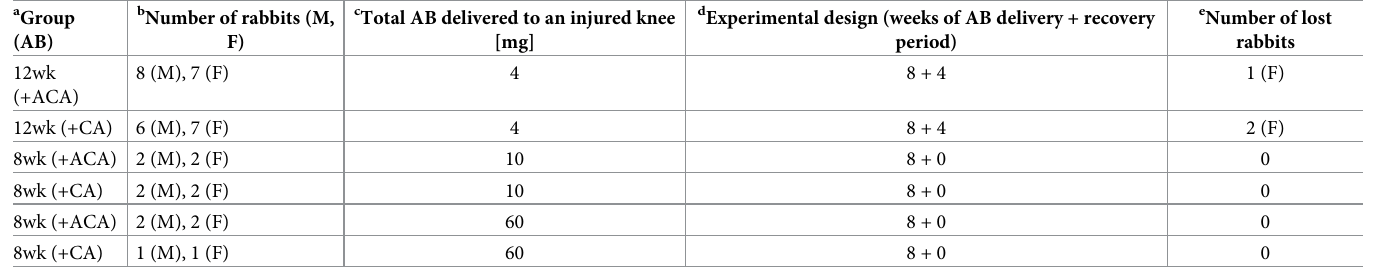
Table 1. A summary of experimental groups and the number of rabbits in the ACA and control